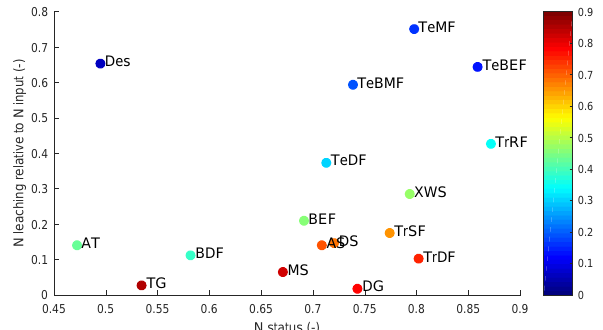
Figure 7. N leaching relative to total N input versus N status for the 17 biomes for the true historical simulation ( + Ndep + clim + CO 2 ). Colours indicate the mean fraction of N lost by fire. TrRF: